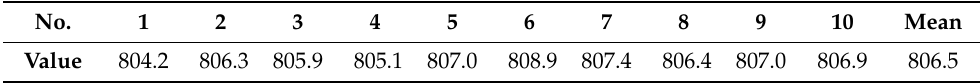
Table 1. Result of discrete measurement of CO 2 standard gas (810.6 ppmv) 1 .